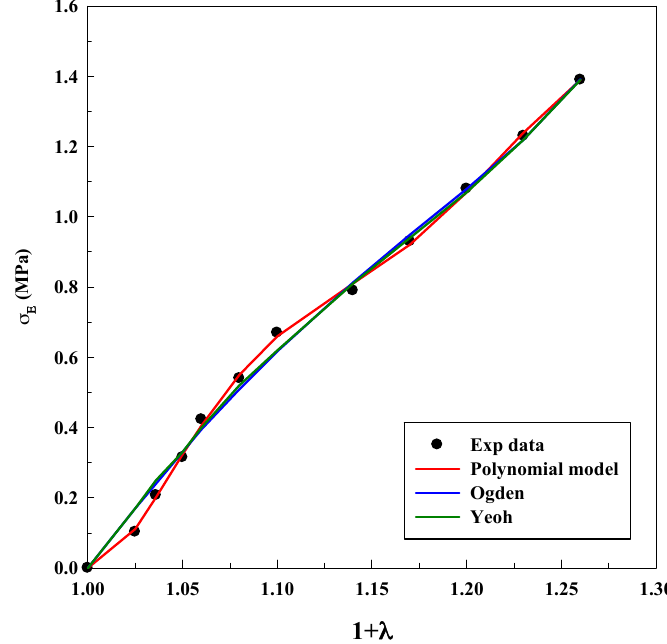
Figure 6. Models fitting of stress–elongation for the system A/G 80/20% v / v at 2% w / w .